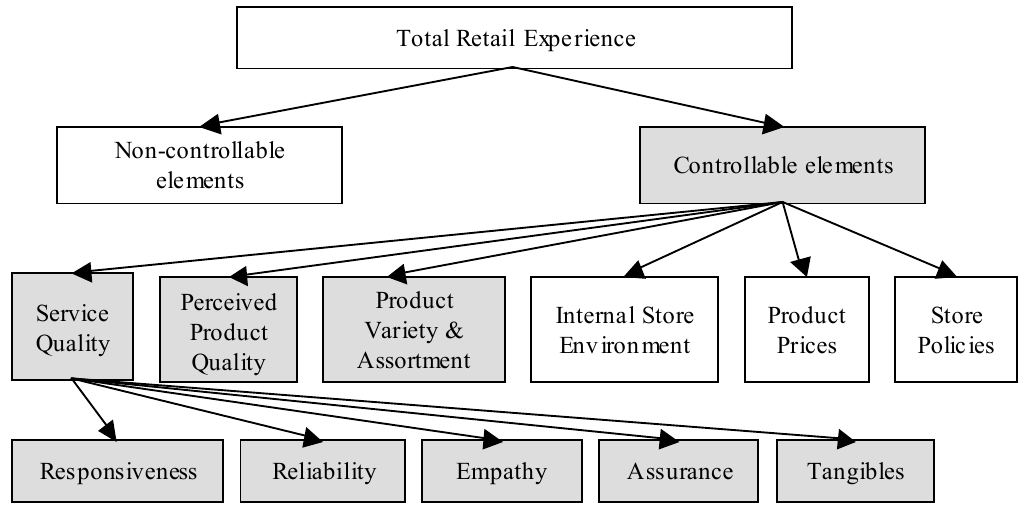
Figure 1 schematic presentation of the theoretical structure of the total retail experience* *The shaded areas represent the dimensions studied in this first phase of the